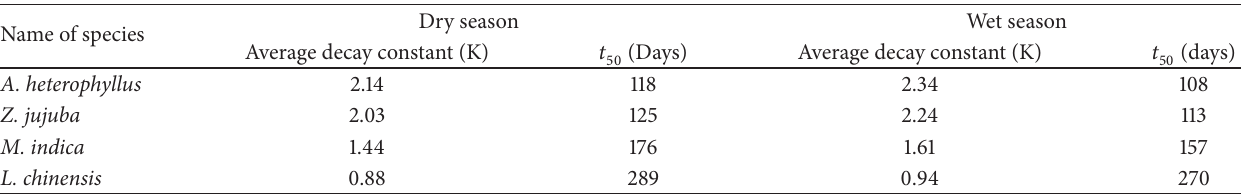
Table 2: Average decay constant and half-life ( 𝑡 50 ) of leaf litter of selected cropland agroforest horticultural tree species during microbial decomposition in dry and wet season.